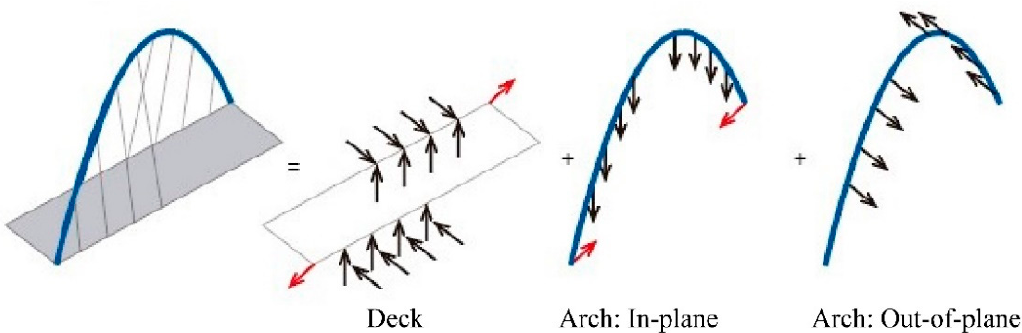
Figure 33. Out-of-plane and in-plane loads in the arch and the deck.